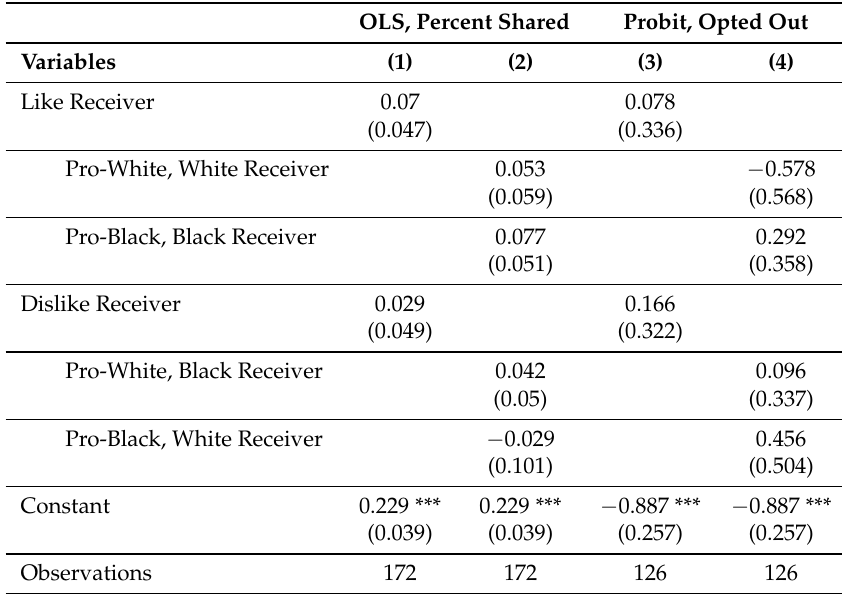
Table 5. Discrete IAT estimations.